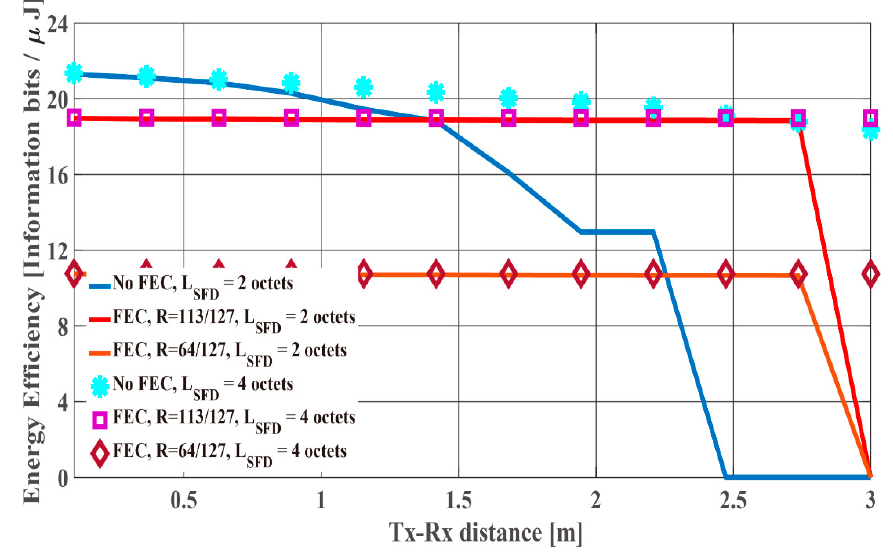
Figure 24. The maximum energy efficiency under the IEEE model CM3 as a function of the Tx-Rx distance.